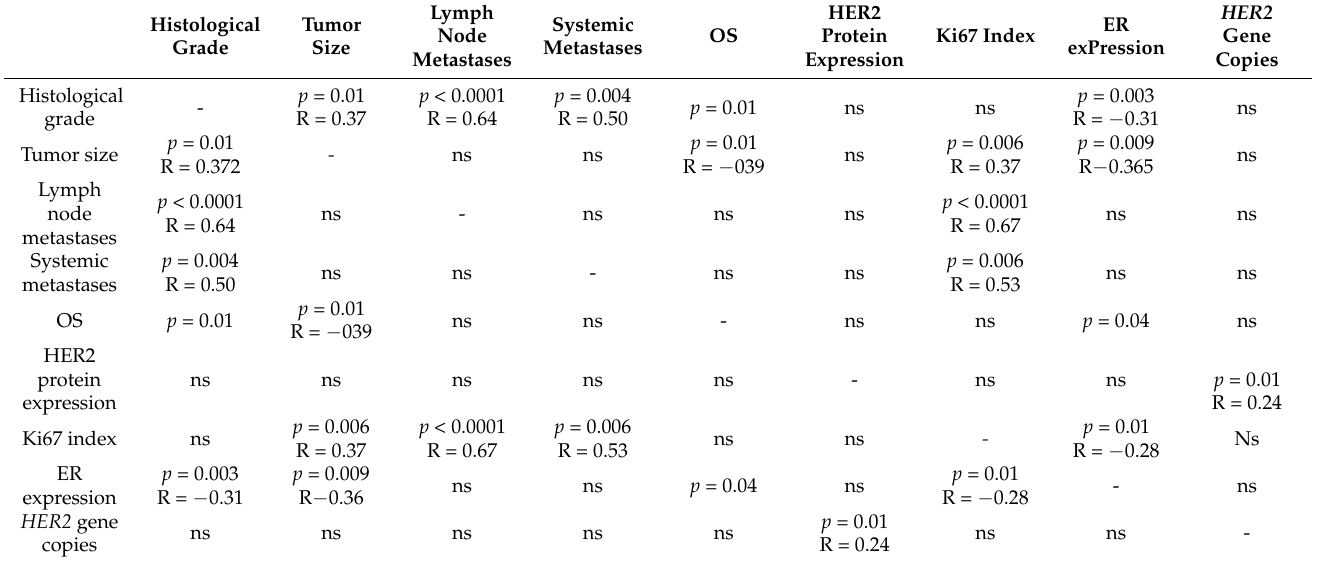
Table 1. Statistically significant association between clinical–pathological parameters, HER2 protein, HER2 gene, ER, and Ki67 index. HER2: human epidermal growth factor receptor 2; ER: estrogen receptor; OS: overall